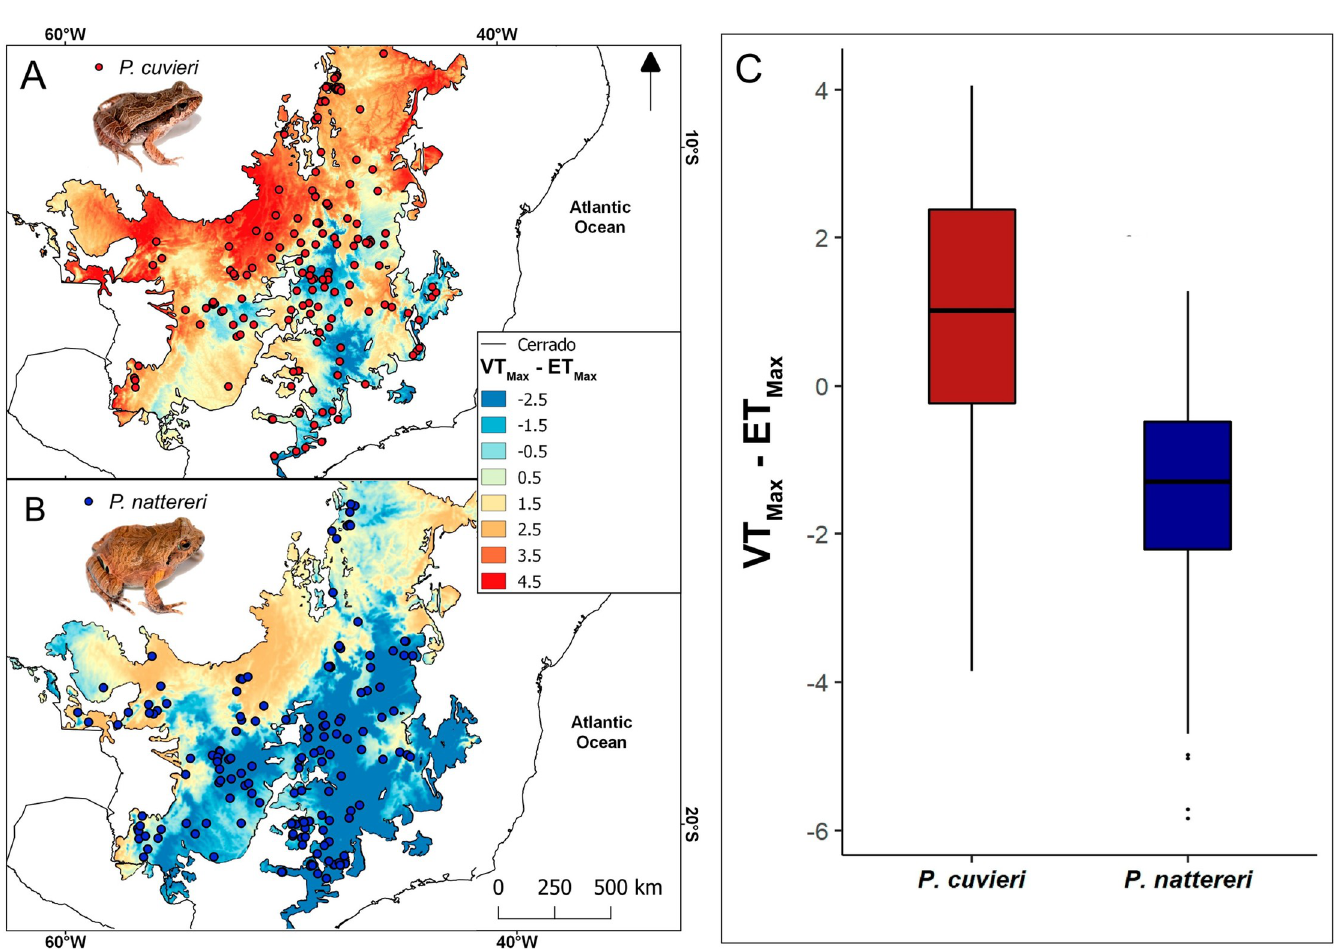
Fig 1. Geographical distribution of the studied species and VT Max —ET Max values throughout their distribution. (A) Distribution of Physalaemus cuvieri ; (B) distribution of Physalaemus nattereri ; and (C) comparison of VT Max —ET Max values at occurrence points between these species in the Cerrado.